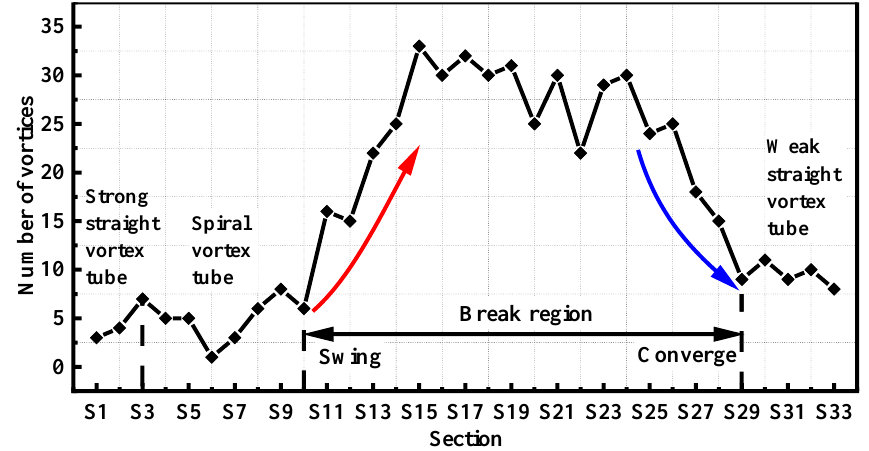
Figure 8. Schematic diagram of image processing process on a 2D section of draft tube. ( a ) Original image; ( b ) binarization processing; ( c ) morphological operation (open operation and closed operation); ( d ) mark vortex.